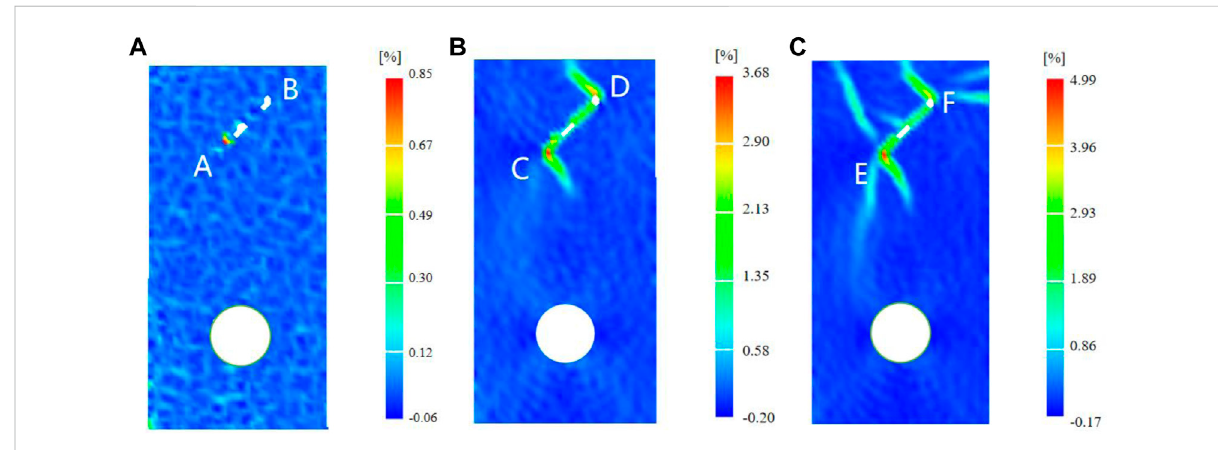
FIGURE 14 α = 45 ° DIC feature diagram. (A-C) , the three stages of compression and densi fi cation, crack initiation, and damage are indicated,